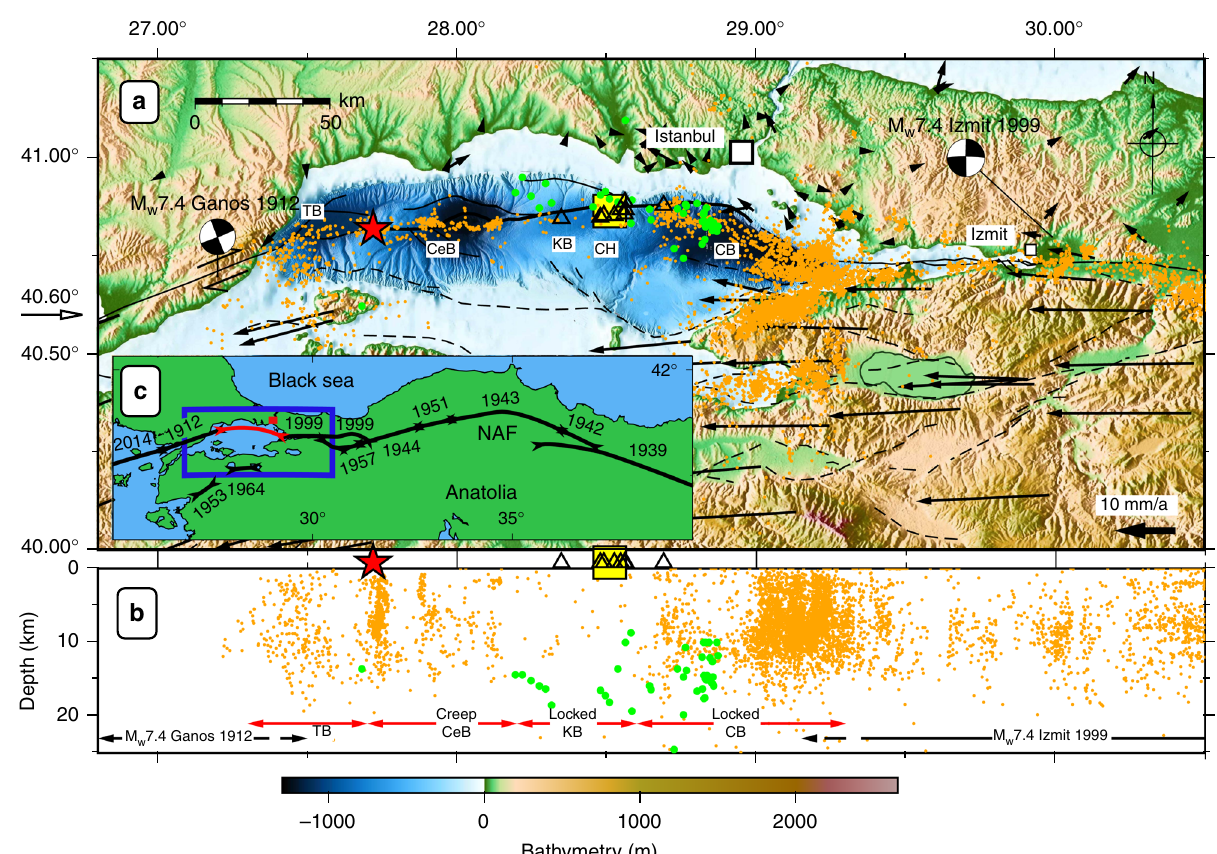
Fig. 1 Overview and tectonic setting of the Sea of Marmara. a Tectonic setting of the NAF (solid line) in the Marmara region with local seismicity (orange dots) between 1999 – 2009 4 and 2010 – 2012 11 . The geodetic acoustic network is located in the yellow box (top center) and the local ocean bottom seismometer (OBS) stations (29/10/2014 – 25/04/2015 and 26/04/2015-13/04/2016) are indicated with triangles. Microseismicity based on the OBS (this study) in the area of the geodetic network is shown with green circles. The red star indicates the location of a recent Turkish-Japanese direct path- ranging network in the western Sea of Marmara 22 . Fault traces of the NAF 29 and GPS displacements relative to stable Eurasia 9 are shown with black arrows and lines. Bathymetry from 30 and topography from 31 . Tekirda ğ basin (TB), Central Basin (CeB), Kumburgaz Basin (KB), Central High (CH) and Ç ı narc ı k Basin (CB) 11 . b Pro fi le view of seismicity north of 40.6°N, same symbols as in panel a. Sedimentary basins are indicated with red arrows and the extent of the Ganos 1912 and Izmit 1999 earthquakes 12 are indicated with black arrows. Creeping 11,12,22 and locked 6 segments of the NAF are labelled. See text for discussion about locked fault beneath the KB and the CB. c Large-scale tectonic setting of north-western Turkey with rupture zones of major earthquakes 6,25 along the North Anatolian Fault